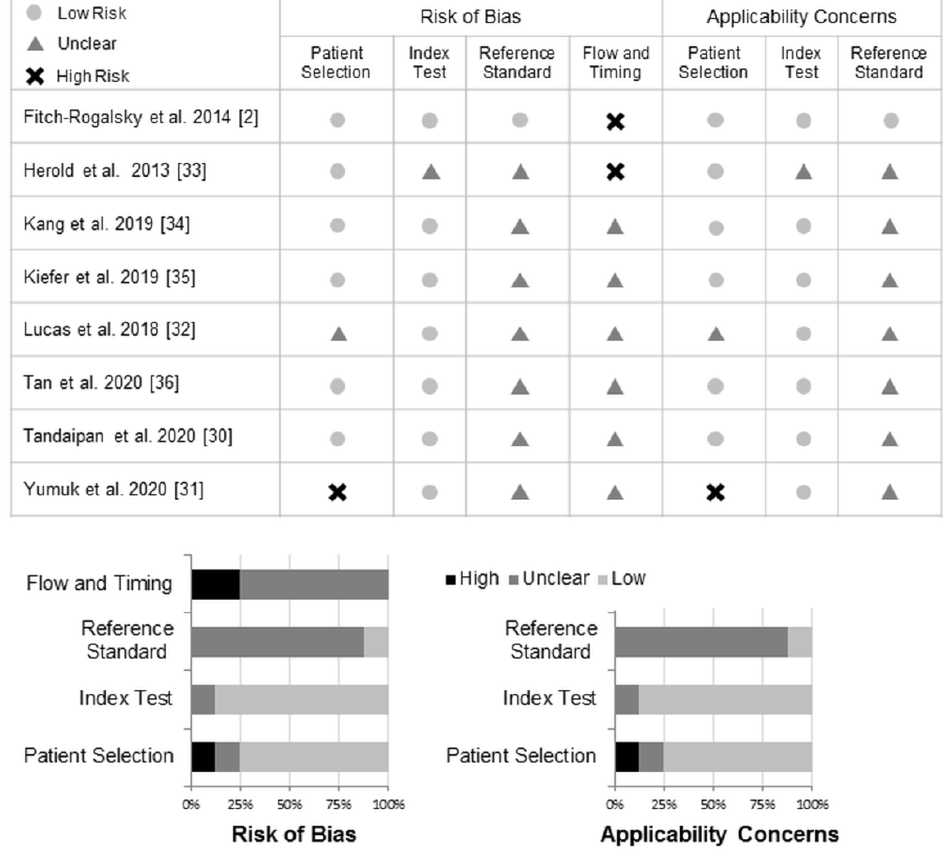
Figure 2. Methodological quality of the included studies.